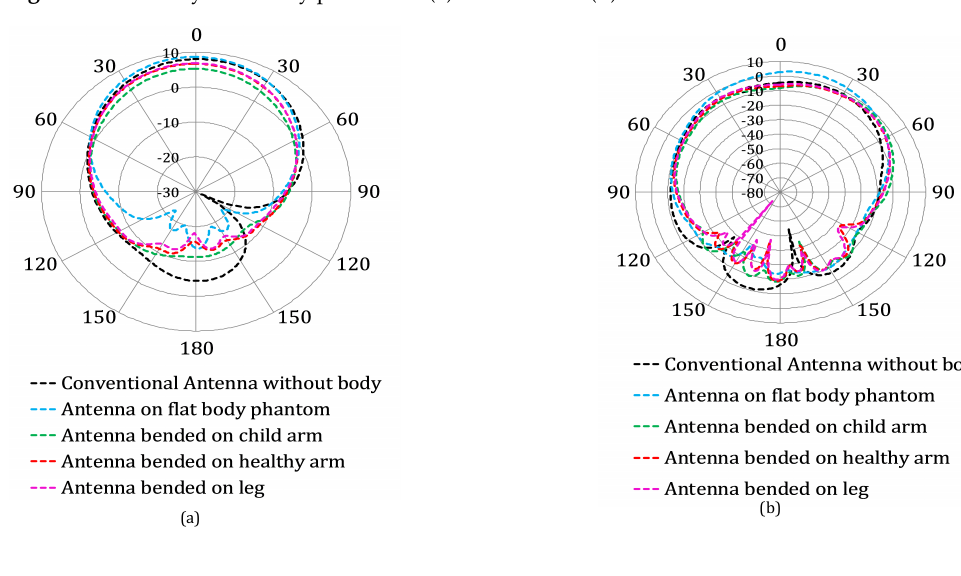
Figure 22. On-body gain patterns at ( a ) 2.5 GHz and ( b ) 5.2